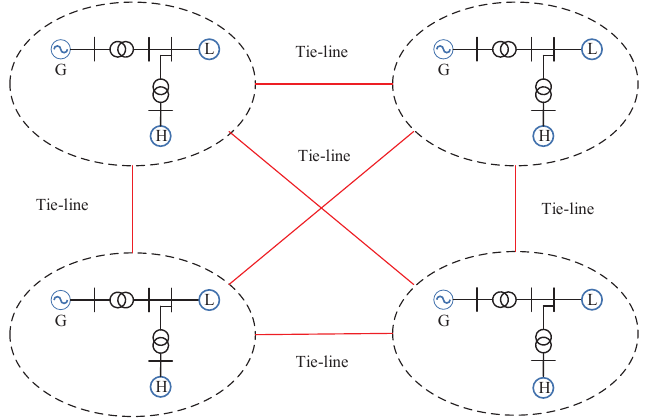
Figure 4. Four area interconnected power system with hybrid energy storage system